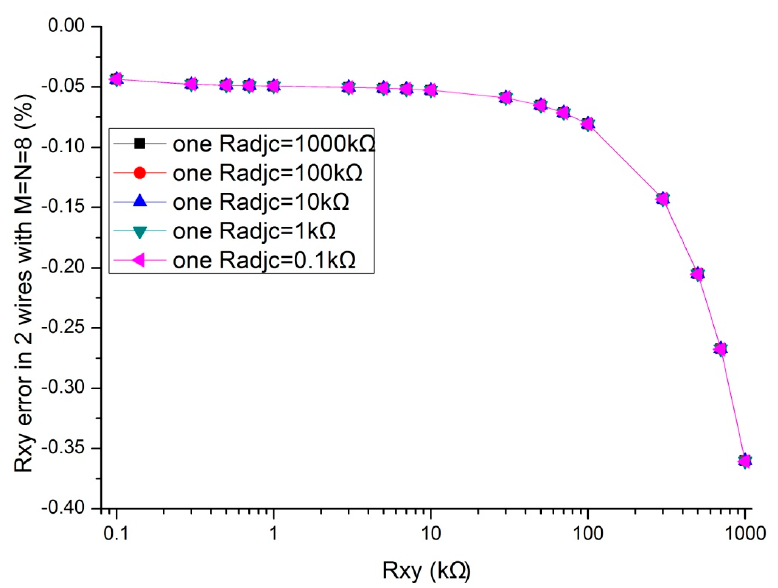
Figure 6. The R adjc effect on R xy errors in the two-wire VF-NSDE circuit.